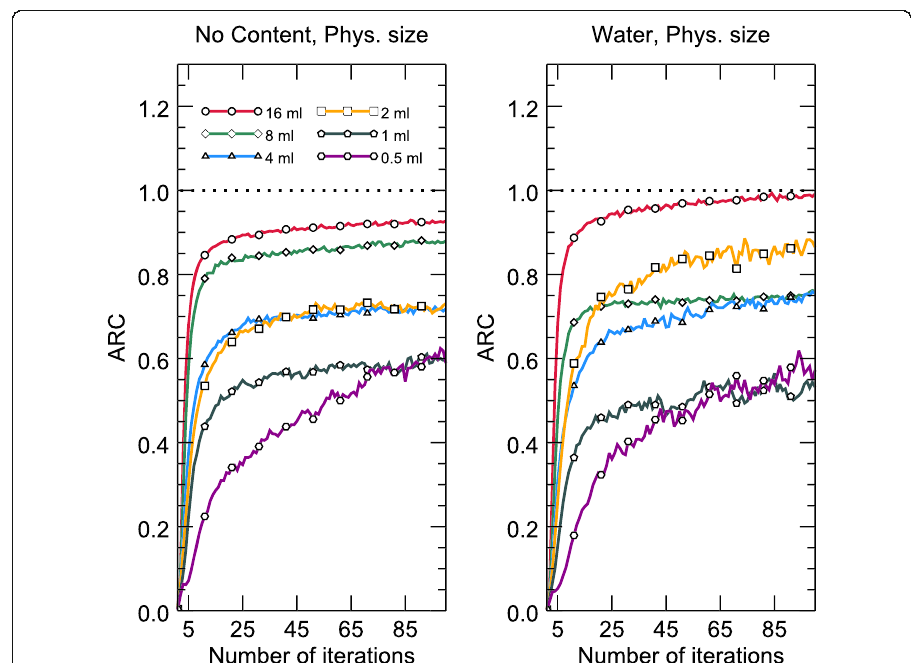
Fig. 4 ARCs for spherical VOIs with diameters equal to the sphere diameter. The results are shown for iterations 1 – 100 for spheres in the empty (left) and water-filled (right) torsos. Only every 10th data point is marked for better clarity. The ARCs increase rapidly initially and continue to increase up to the user-selected endpoint of 100 iterations